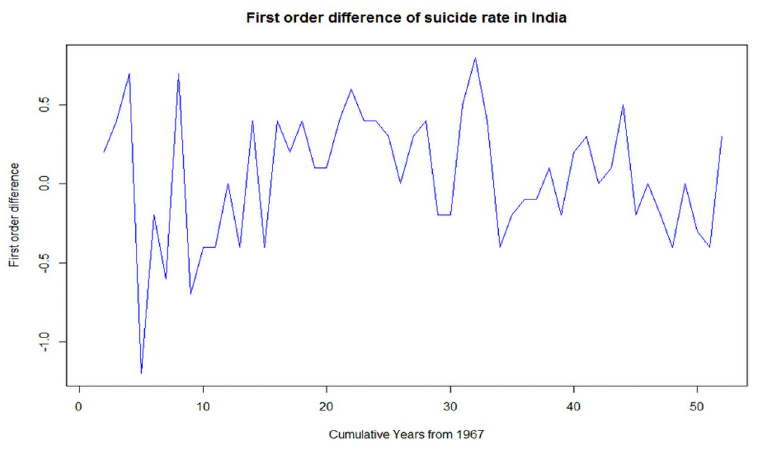
Fig 4. First order difference of suicide rate in